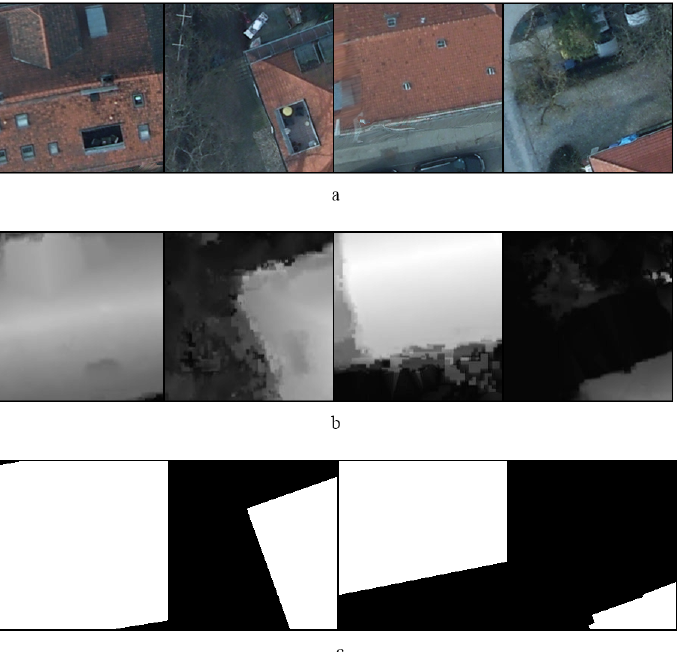
Figure 3. ( a ) RGB image patch. ( b ) DSM patch. ( c ) Corresponding binary thematic map. Building pixels are displayed in white, whereas non-building pixels are displayed in black.